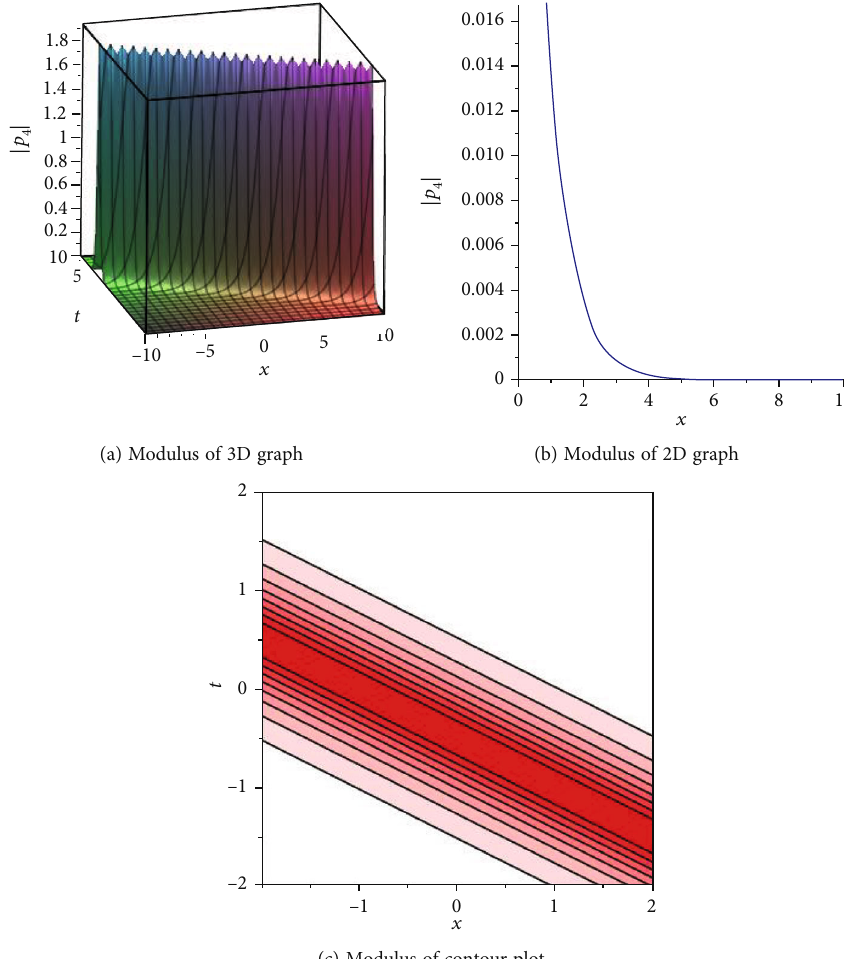
= 1, a = 2, a = 1, a = 1/2, k 1 2 3 4